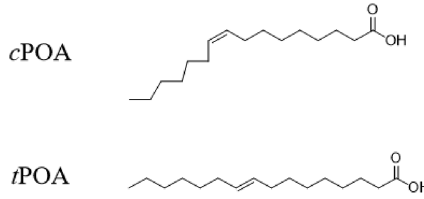
Figure 1. Structures of c POA and t POA.